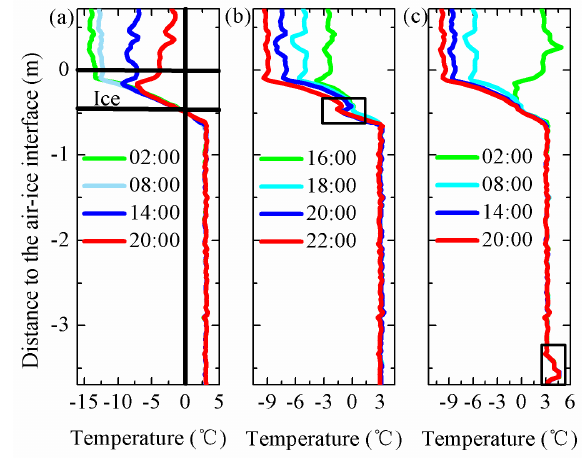
Figure 20. ( a ) Temperature profiles at 02:00, 08:00, 14:00 and 20:00 on 11 February. ( b ) Temperature profiles at 16:00, 18:00, 20:00 and 22:00 on 13 February. ( c ) Temperature profiles at 02:00, 08:00, 14:00 and 20:00 on 14 February. Black boxes indicate abnormal temperature values.